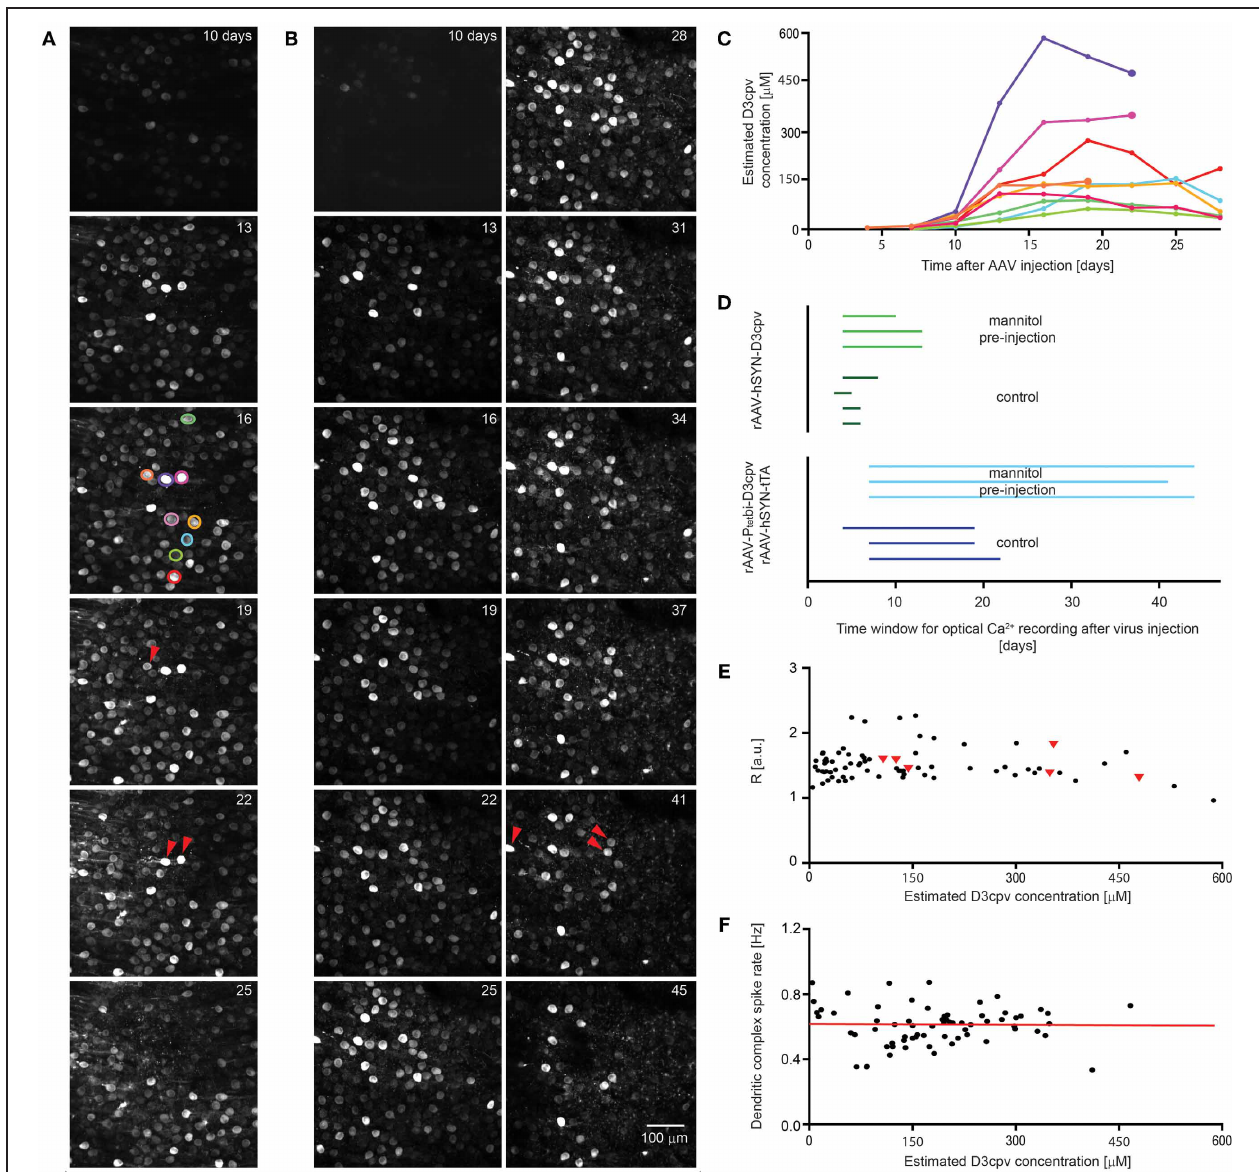
FIGURE 6 | Extension of time window for imaging by systemic mannitol pre-injection. Images showing the time course of expression of D3cpv (A) without and (B) with systemic mannitol injection. Red arrowheads indicate cells that disappear in the next image taken 3 days later. (C) Time course of estimated D3cpv concentrations of single neurons indicated in (A) by color show no clear correlation between D3cpv concentration and cell death within the following 3 days indicated by a larger symbol. (D) The time window for calcium imaging in PCs and interneurons in the cerebellum doubles with systemic mannitol injection. Each line, representing one animal, starts when expression was high enough for functional imaging and ends 2–3